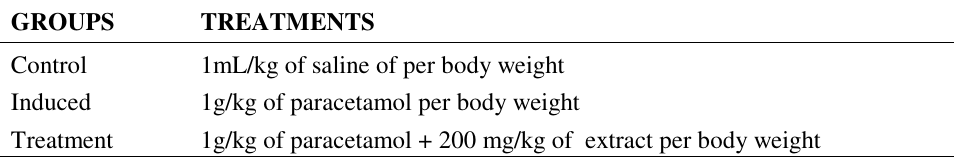
Table 2. Grouping of mice and treatment